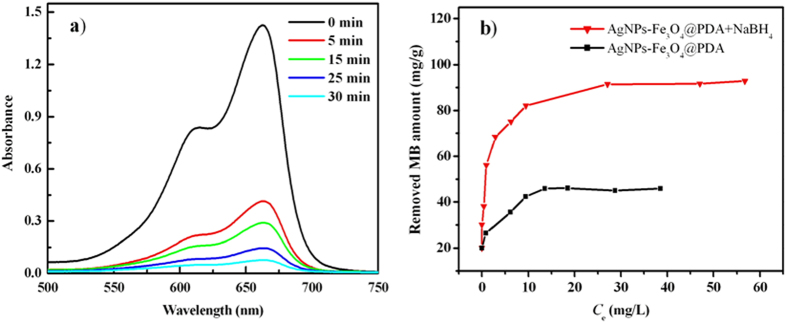
(a) Effect of contact time on MB removal by AgNPs-Fe3O4@PDA/NaBH4; (b) MB removal by AgNPs-Fe3O4@PDA/NaBH4 and Fe3O4@PDA/NaBH4 systems.